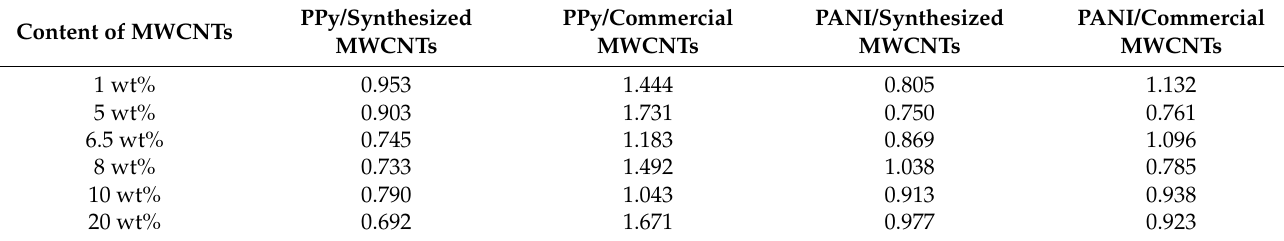
Table 2. I D /I G quotients compute from Figure 8, for PPy and PANI composites. Content of